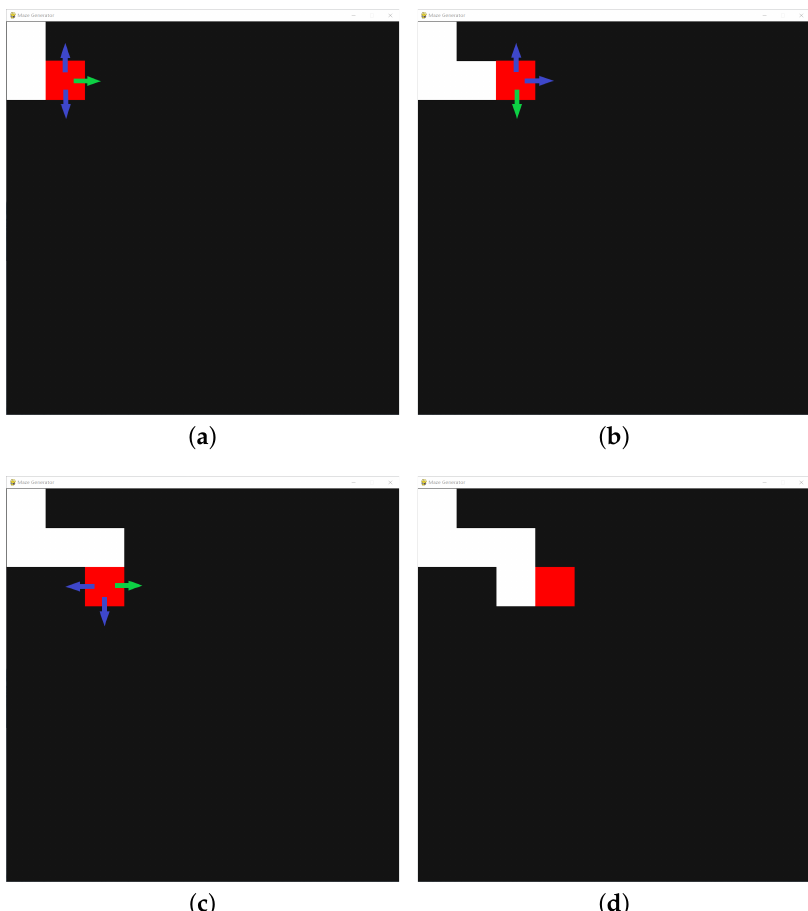
Figure 5. A complete map scene is gradually generated as the red grid moves into the black area: ( a ) step 1, ( b ) step 2, ( c ) step 3, ( d ) step 4. The arrows indicate all possible moving directions, and the green arrow indicates that the direction is randomly selected as the moving direction of the red